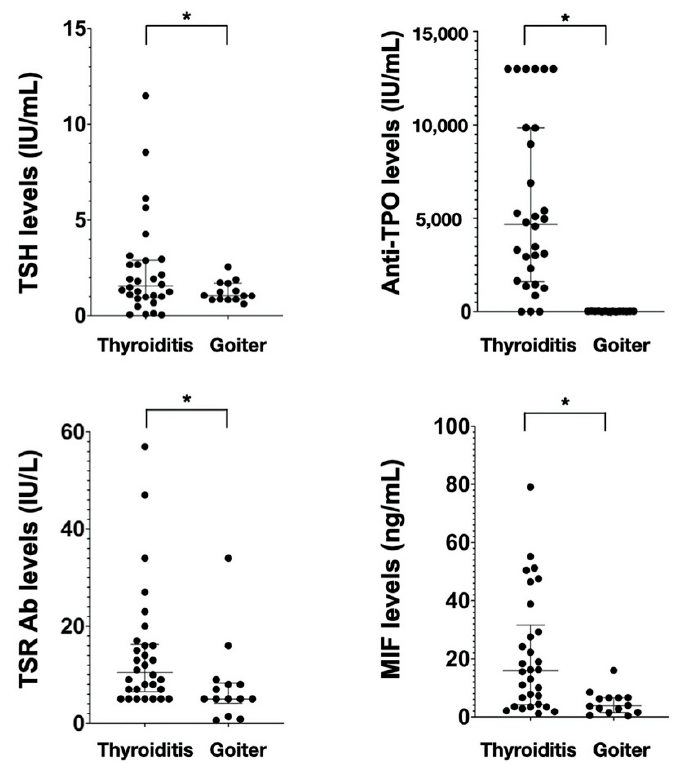
Figure 1. Serum levels of TSH, TSH-receptor Ab, anti-TPO Ab, and MIF in different groups. Values are presented as median ± IQR. TSR Ab, TSH-receptor antibody; * Statistically significant difference. Table 2. Correlation of MIF, TDS, OP time, and blood loss in different